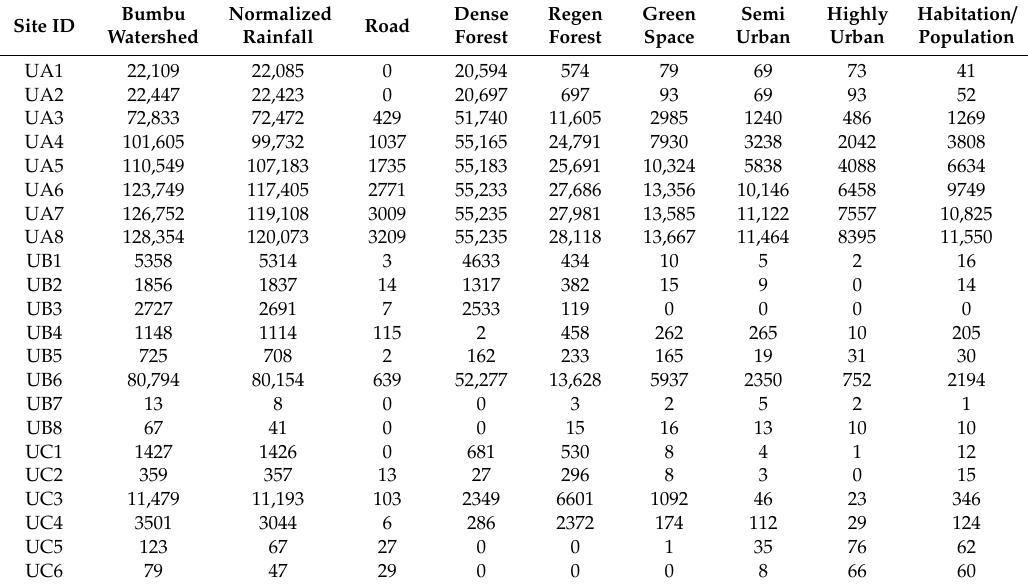
Table 2. Raw runo ff values for di ff erent factors at 22 WQ sampling sites in the Bumbu Watershed. Site ID